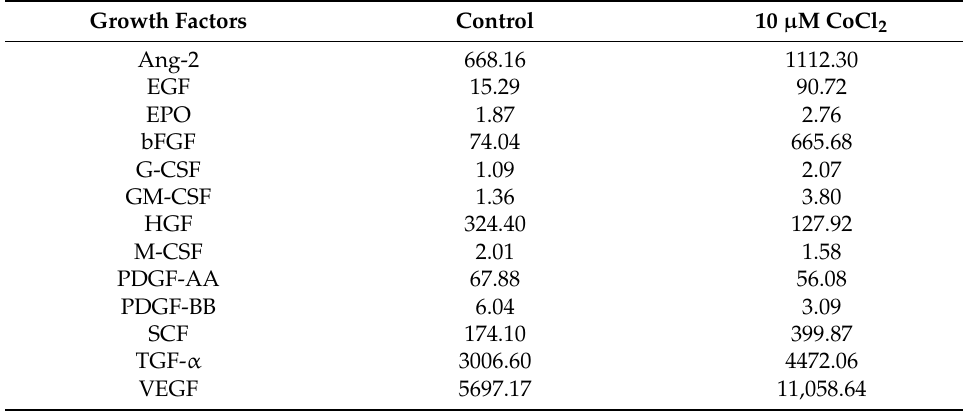
Figure 3. ( A ) : growth factor distribution; ( B ) : Inflammatory cytokines distribution. Table 5. Effect of CoCl 2 on growth factor secretion by DPSCs.